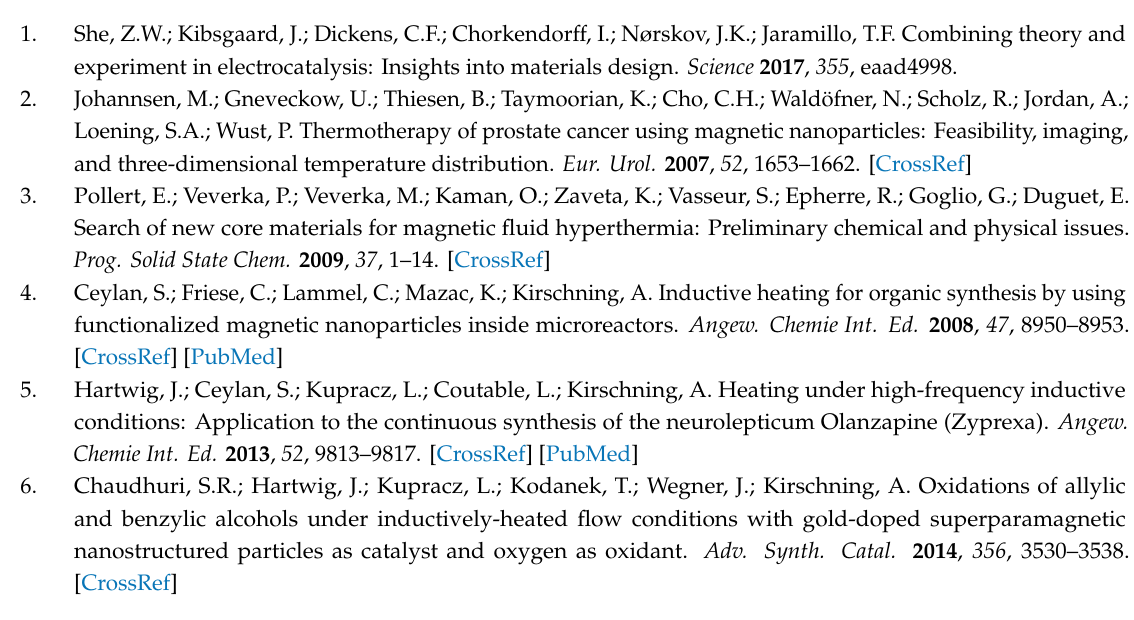
Table S1: Vessel’s surface temperature, pressure and solution color as the function of time into AC-field heating, Figure S1: Vector representation of the µ 0 H on a plane through the center of the inductor coil, Figure S2: Color map of the µ 0 H magnitude on the plane through the center of the coil, Figure S3: XRD powder pattern of the MN-C, Table S2: Estimated crystallite size and weight fraction of the corresponding crystalline phase, room-temperature magnetic properties and specific surface area of the MN-C, Figure S4: BF and HAADF STEM images of the MN-C, Figure S5: Raman spectrum of the MN-C, Figure S6: BF and HAADF STEM images of the CH-Ru, Figure S7: Recycling of the CH-Ru